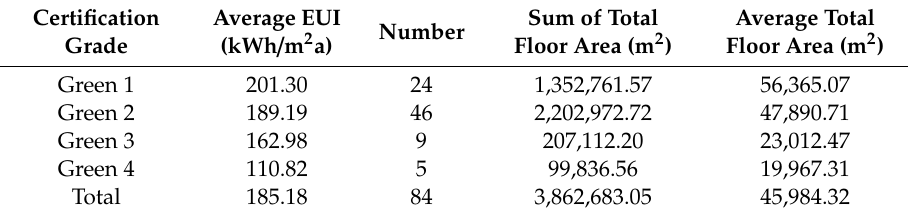
Table 7. Average EUI and average total floor area by G-SEED certification class.